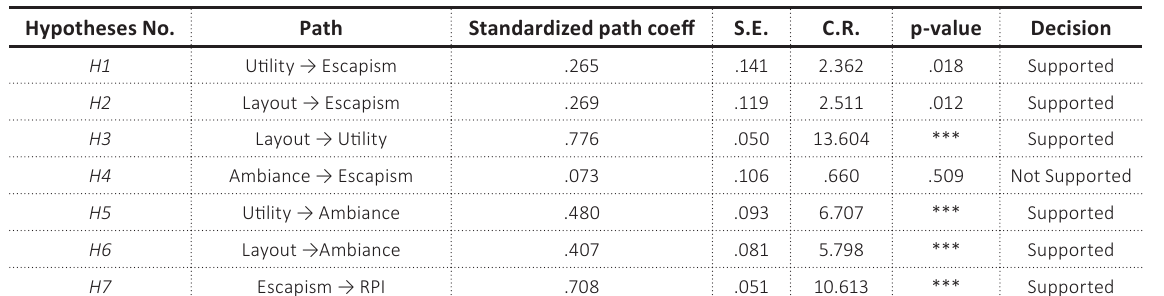
Table 4. Hypotheses